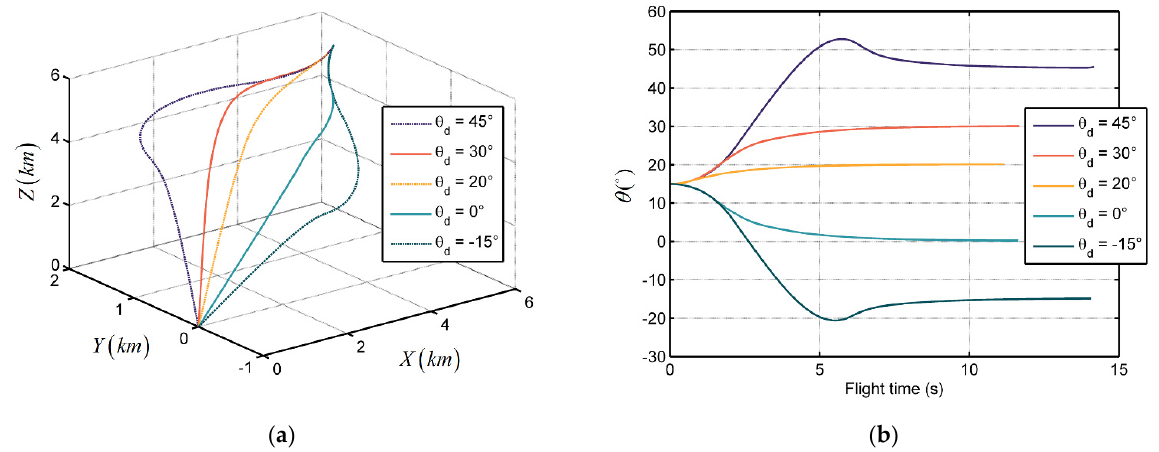
Figure 6. The performance of the proposed guidance law with different desired terminal azimuth angles: ( a ) Relative distance trajectories; and ( b ) LOS angles.